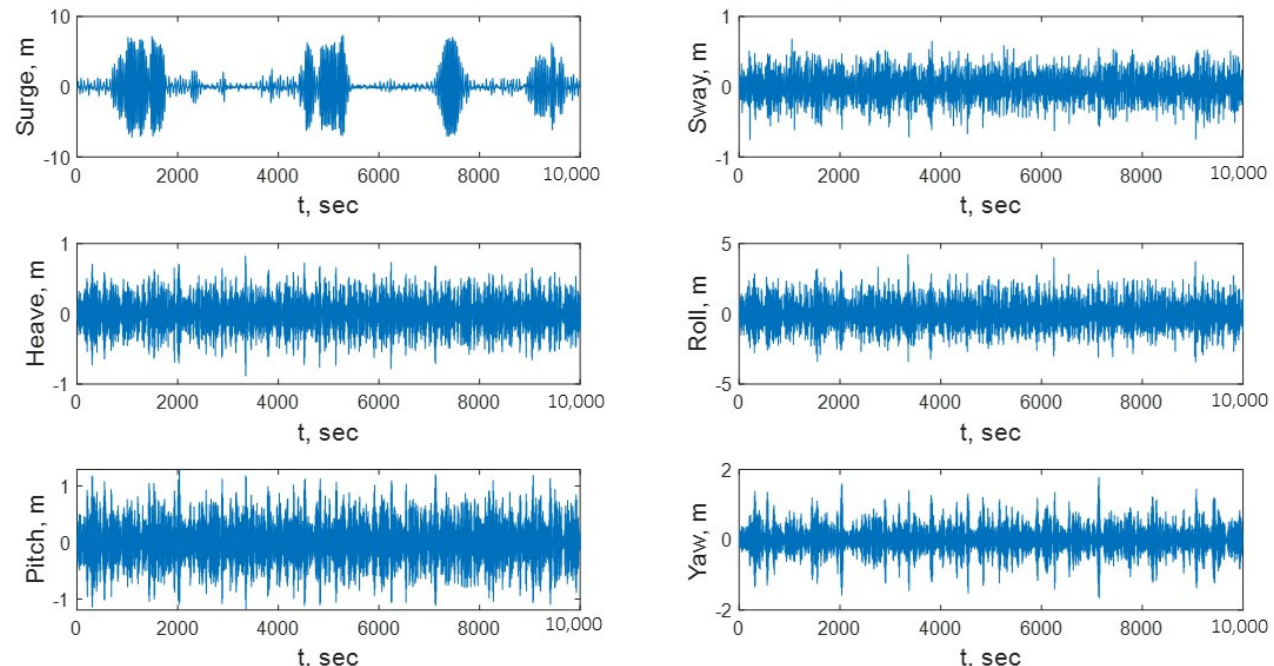
Figure A4. Load case c4 (H mo = 3.5 m)—wave frequency position. The surge and sway positions are relative to the position of the Delta, the other positions are absolute position of the ship.